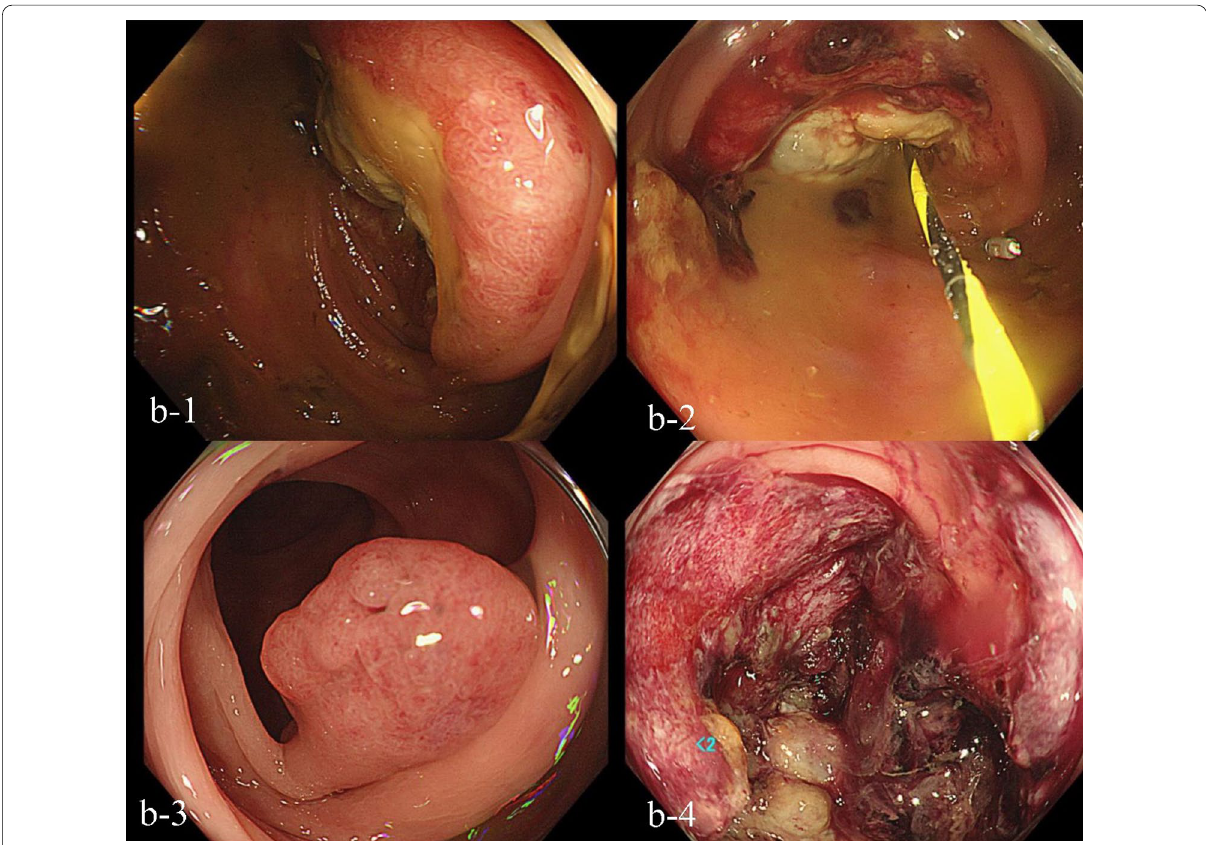
Fig. 2 Colonoscopy findings. b-1 A circumferential type 2 tumor was observed in the descending colon. Categorized into Group 5 after biopsy. b-2 A colon stent was placed at the same site. b-3 A polyp was observed in the sigmoid colon. b-4 A type II tumor with a 75% circumference was observed in the rectum. Categorized into Group 5 after